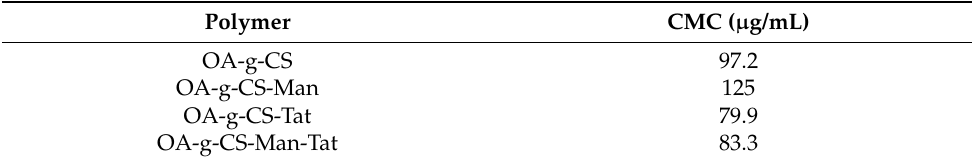
Table 1. Critical micelle concentration of different polymers.